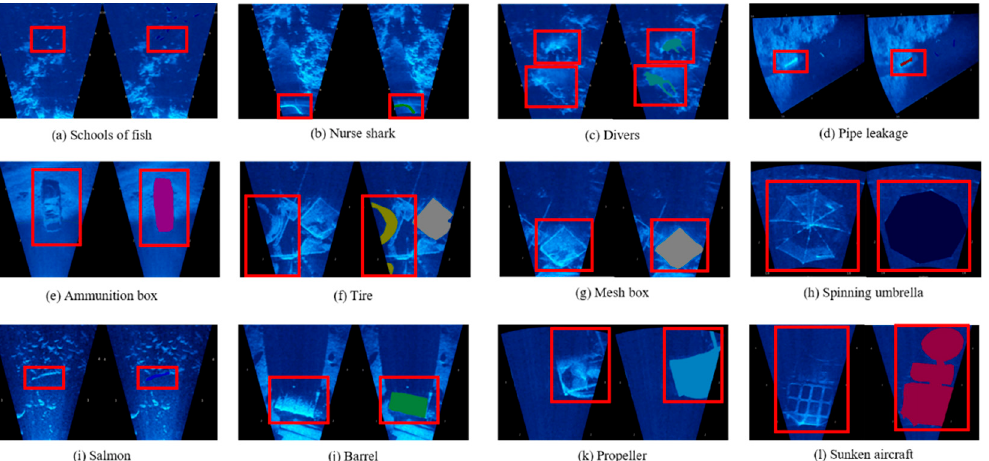
Figure 11. Images of each class and their labeled information images. The red box in each subfigure indicates the location of the objects in that class, and different colors are used to show the different classes, as shown in subfigures ( a – l ).